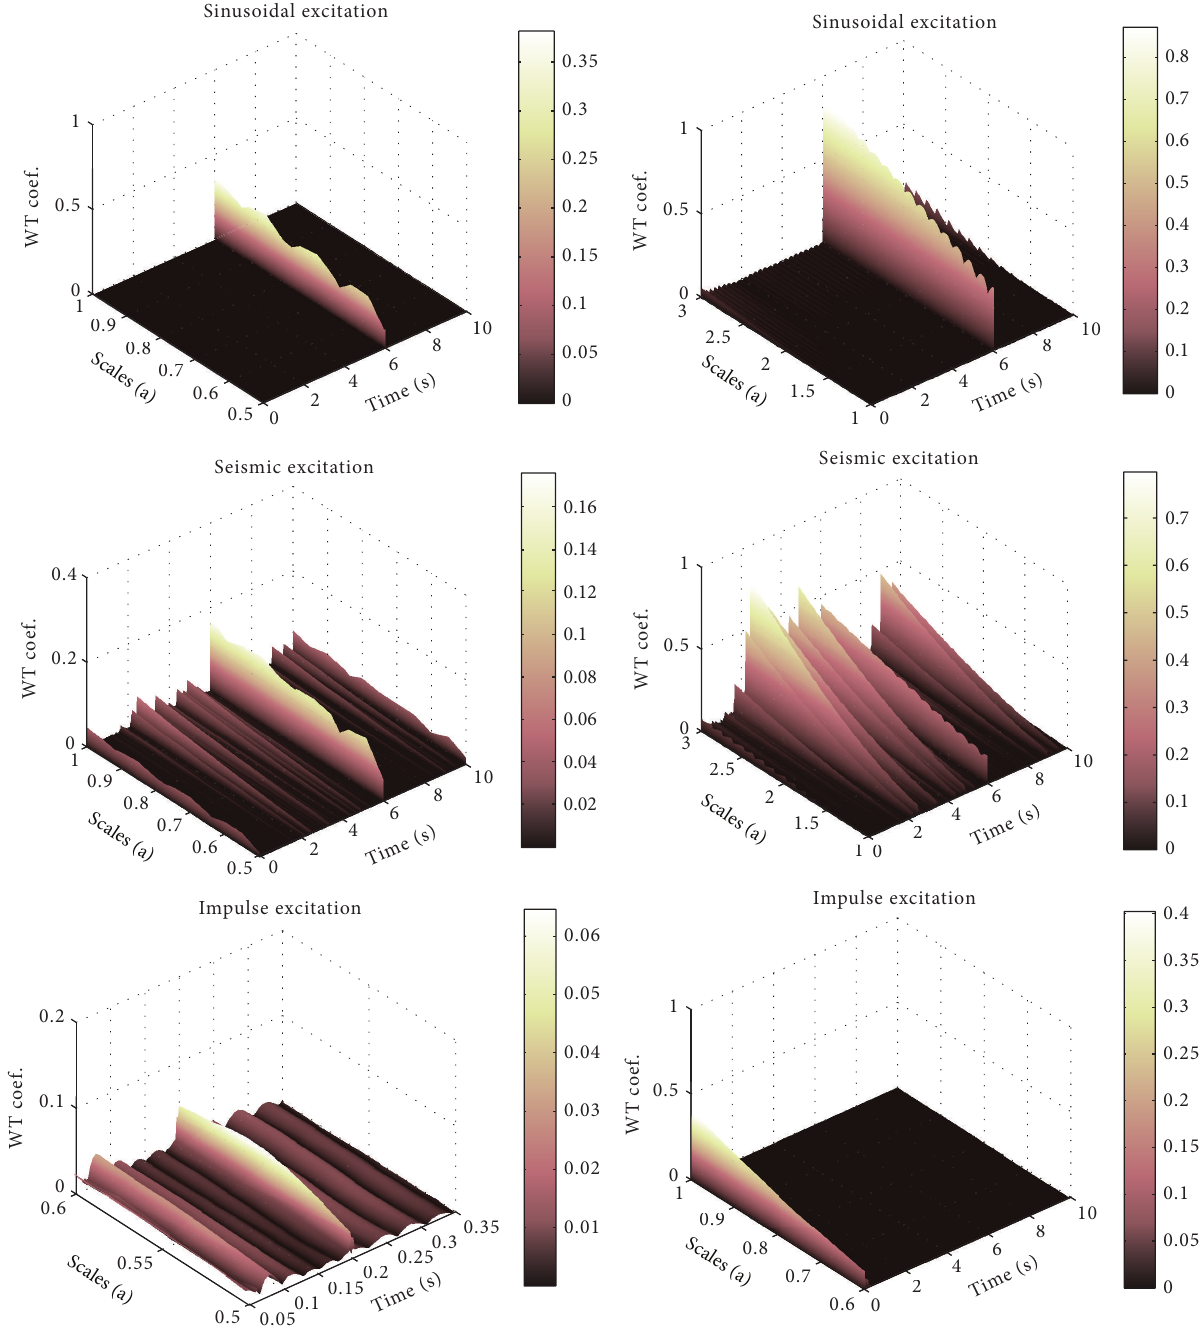
Figure 4: Damage detection under different decomposition